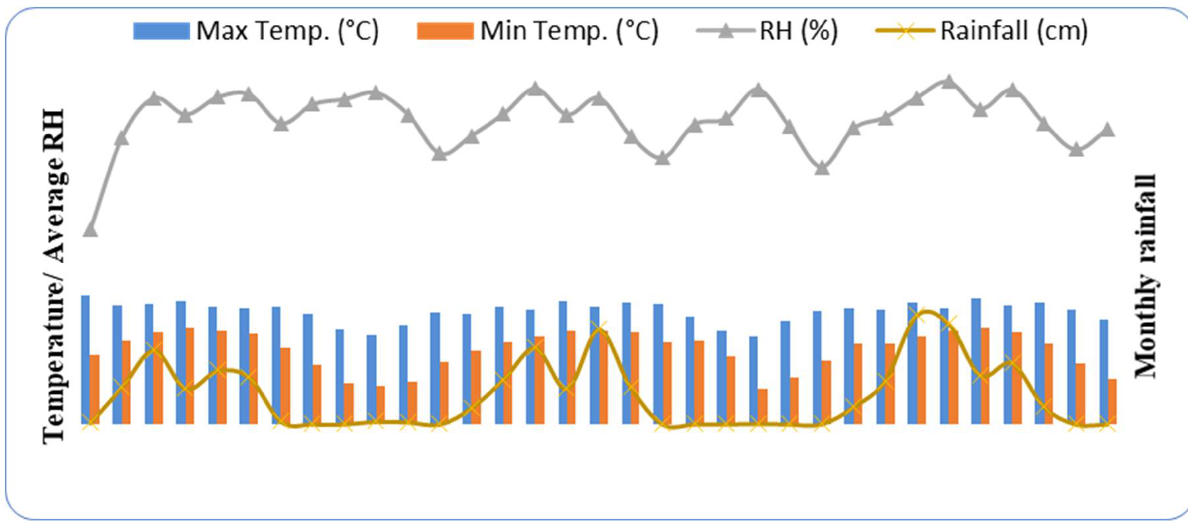
Figure 1. Rainfall, temperature and relative humidity of the study area.